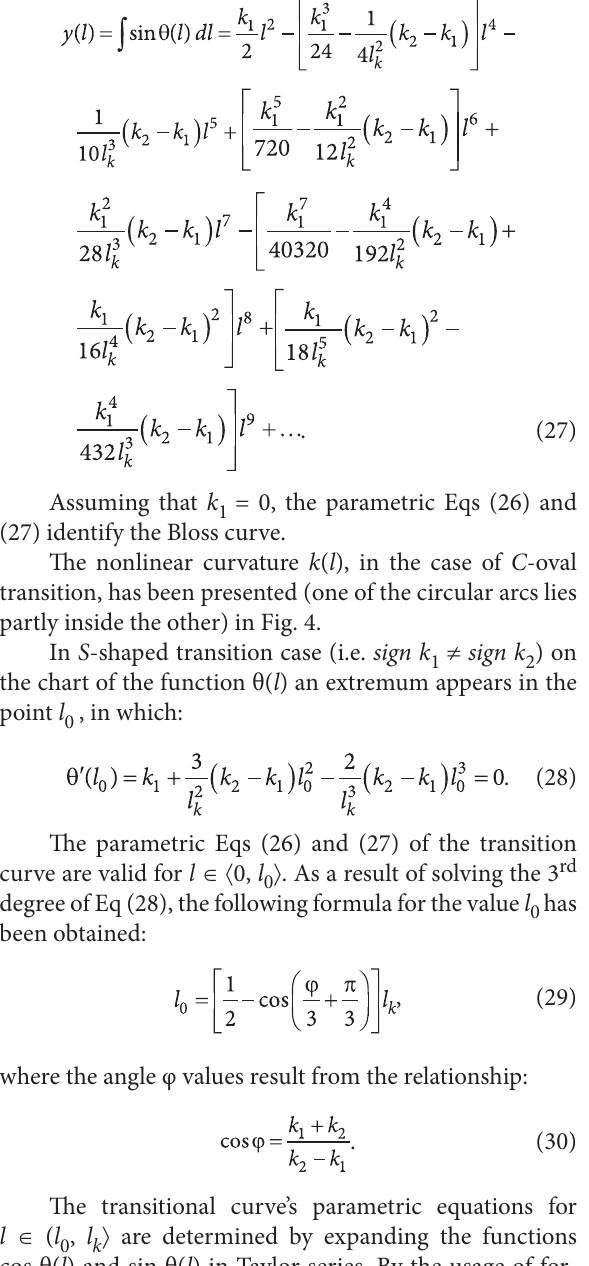
Fig. 4. Nonlinear curvature k ( l ) chart for C -oval joining of circular arcs with curvatures rad/m and rad/m ( l k = 75 m)